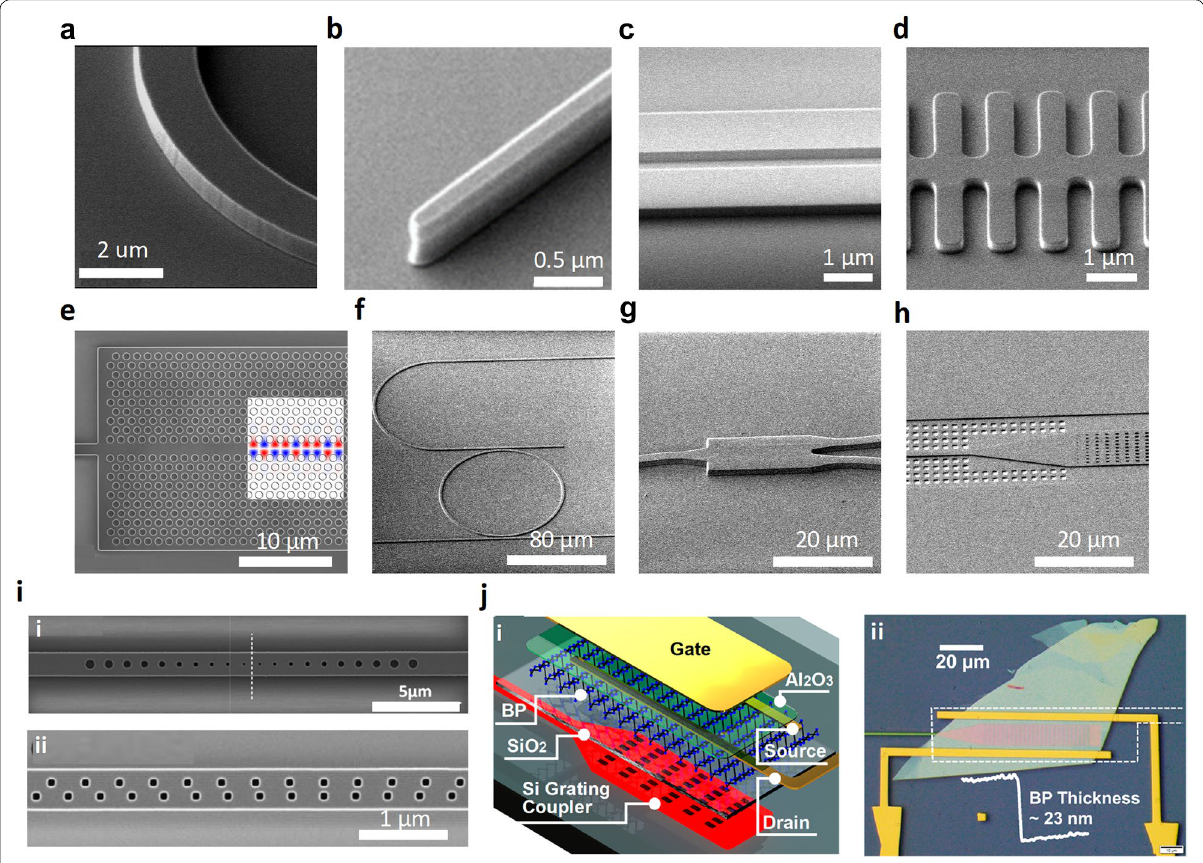
Fig. 5 MIR nanophotonic building blocks. a Waveguide bends (Reproduced with permission from [105]). b Tapered fiber-to-chip coupler (Reproduced with permission from [105]). c Directional coupler. d 1D grating slow light waveguide (Reproduced with permission from [96]). e 2D PhC slow light waveguide (Reproduced with permission from [97]). f Add-drop filter (Reproduced with permission from [143]). g Multimode interferometer (Reproduced with permission from [143]). h Grating coupler with releasing holes. i Nanocavities, (i) with tapered hole radius (Reproduced with permission from [127]), (ii) aperiodic deterministic nanobeam (Reproduced with permission from [128]). j Black-phosphorus-based waveguide integrated on-chip photodetector, (i) schematic of the device, (ii) optical image. (Reproduced with permission from